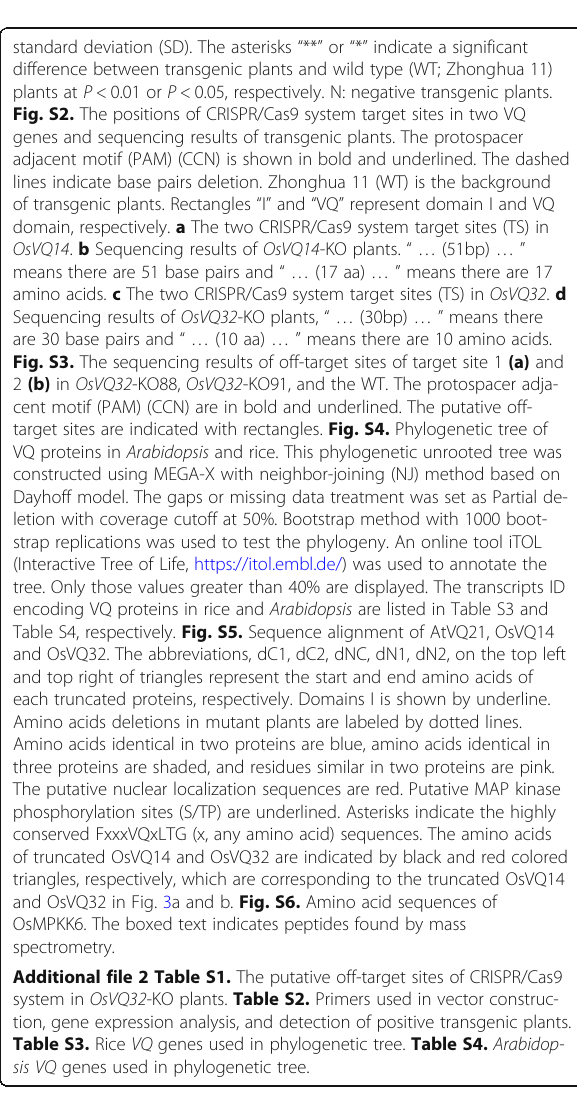
sis VQ genes used in phylogenetic